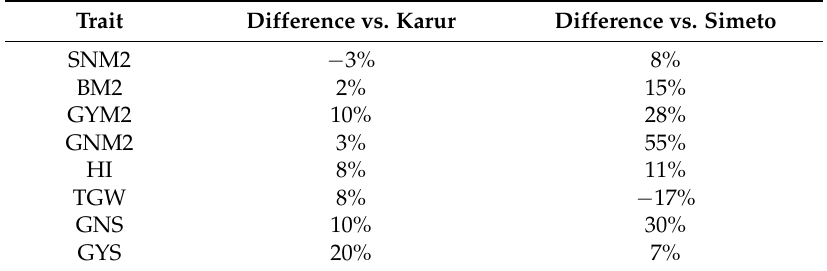
Table 2. Percentage differences between R117-11-20 triple recombinant line and the two control cultivars Karur and Simeto for the relevant yield traits (see Table 1 for symbols). Trait Difference vs. Karur Difference vs. Simeto SNM2 − 3%